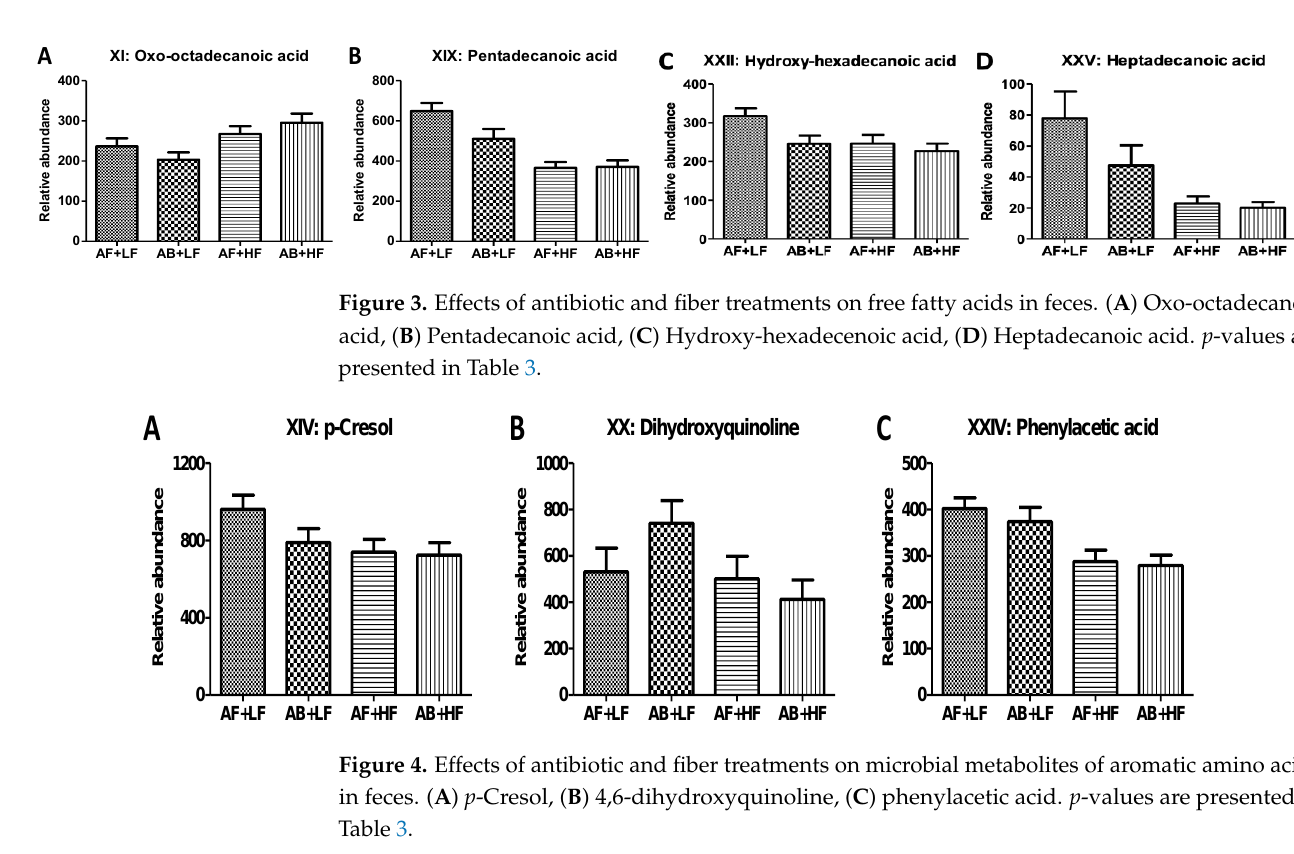
Figure 2. Effects of antibiotic and fiber treatments on lysophophoslipids in feces. ( A ) LysoPC(16:0), ( B ) LysoPC (18:2), ( C ) LysoPC (18:1), ( D ) LysoPE (15:0), ( E ) LysoPE (16:0). p- values are presented in